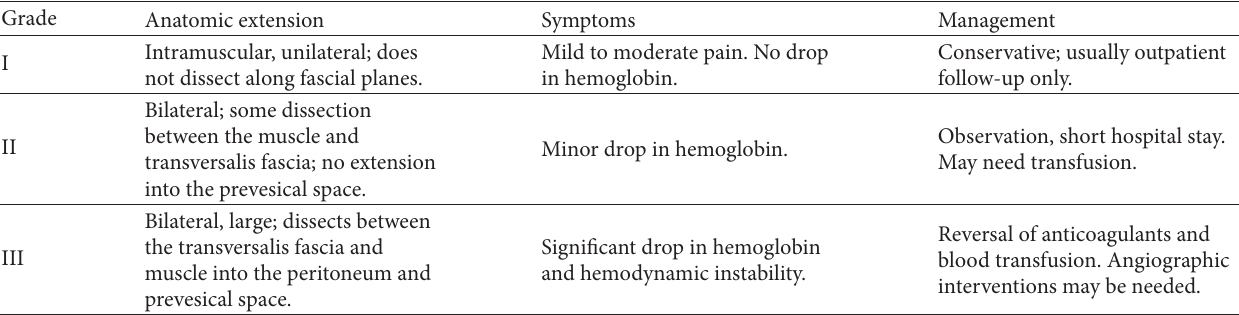
Table 2: Berna and Osinbowale RSH classification. Computed tomography severity grades and suggested management strategy, modified and reprinted with permission from Osinbowale and Bartholomew